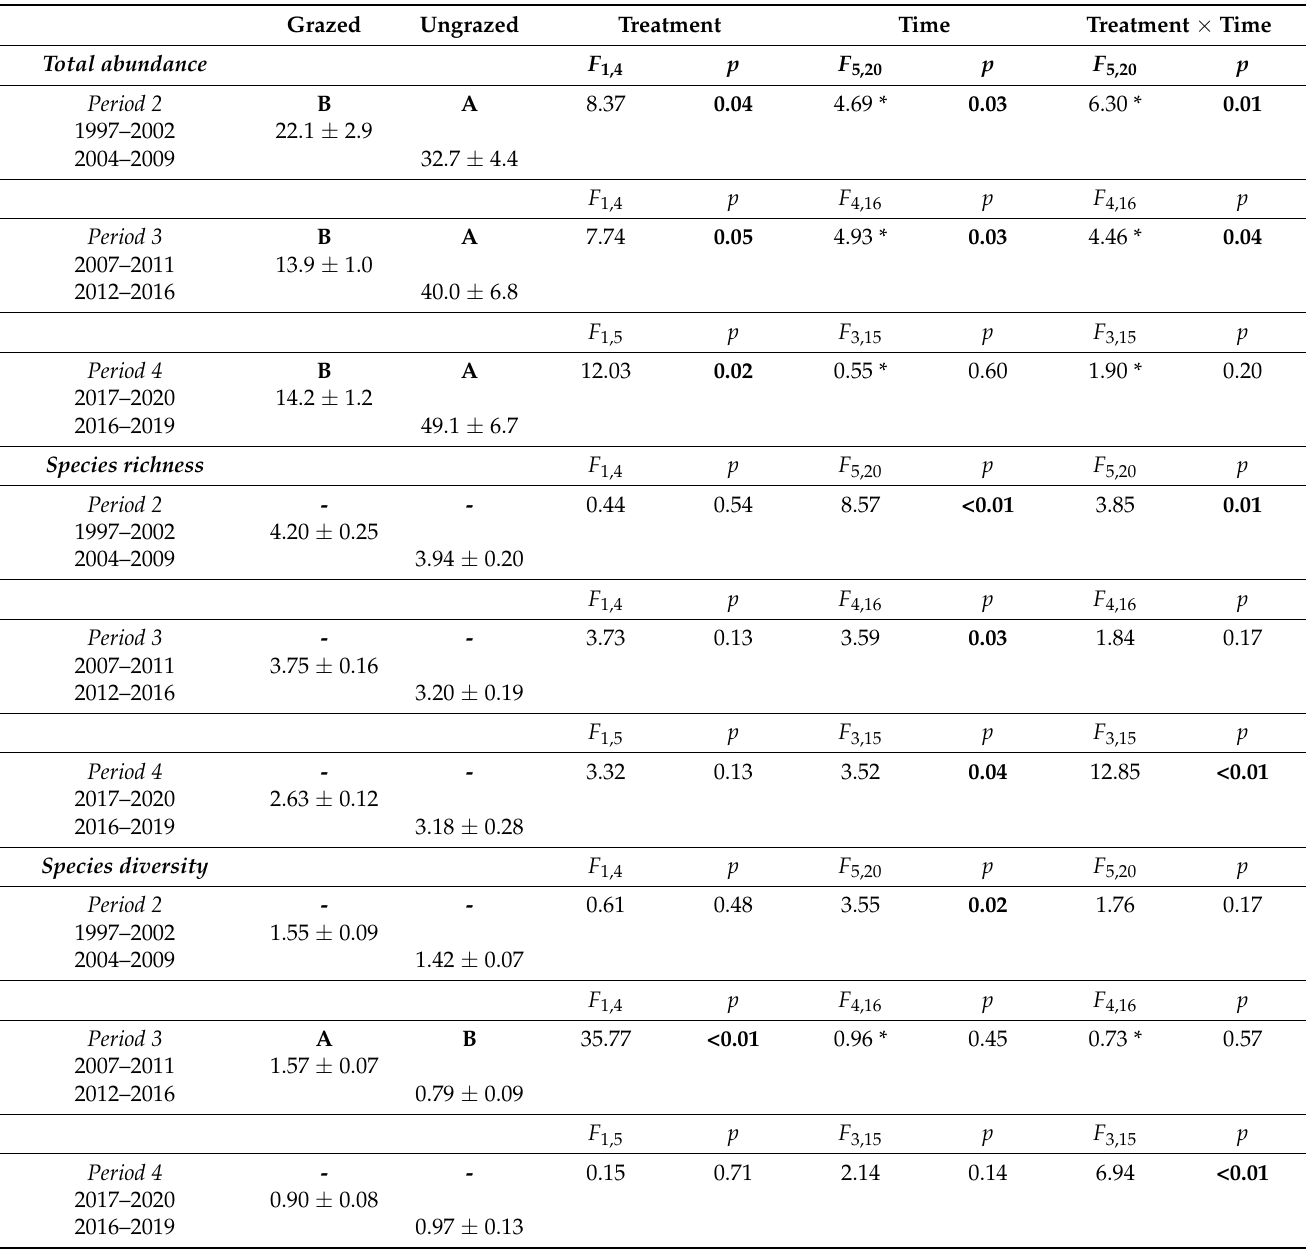
Table 6. Overall mean ( n = 3 × 6; 3 × 5; 3 or 4 × 4; sites × years) ± SE annual total abundance, species richness, and species diversity of forest-floor small mammals in grazed (Summerland) and ungrazed (Golden) clearcut sites for comparable years post-harvest for the CC-GR study in southern BC, Canada 1997 to 2020, and results of RM-ANOVA for Periods 2 , 3 , and 4 . Within a row, columns of mean values with different letters are significantly different. F -values identified by * were calculated using an H-F correction factor, which decreased the stated degrees of freedom due to correlation among repeated measures. Significant values are given in bold